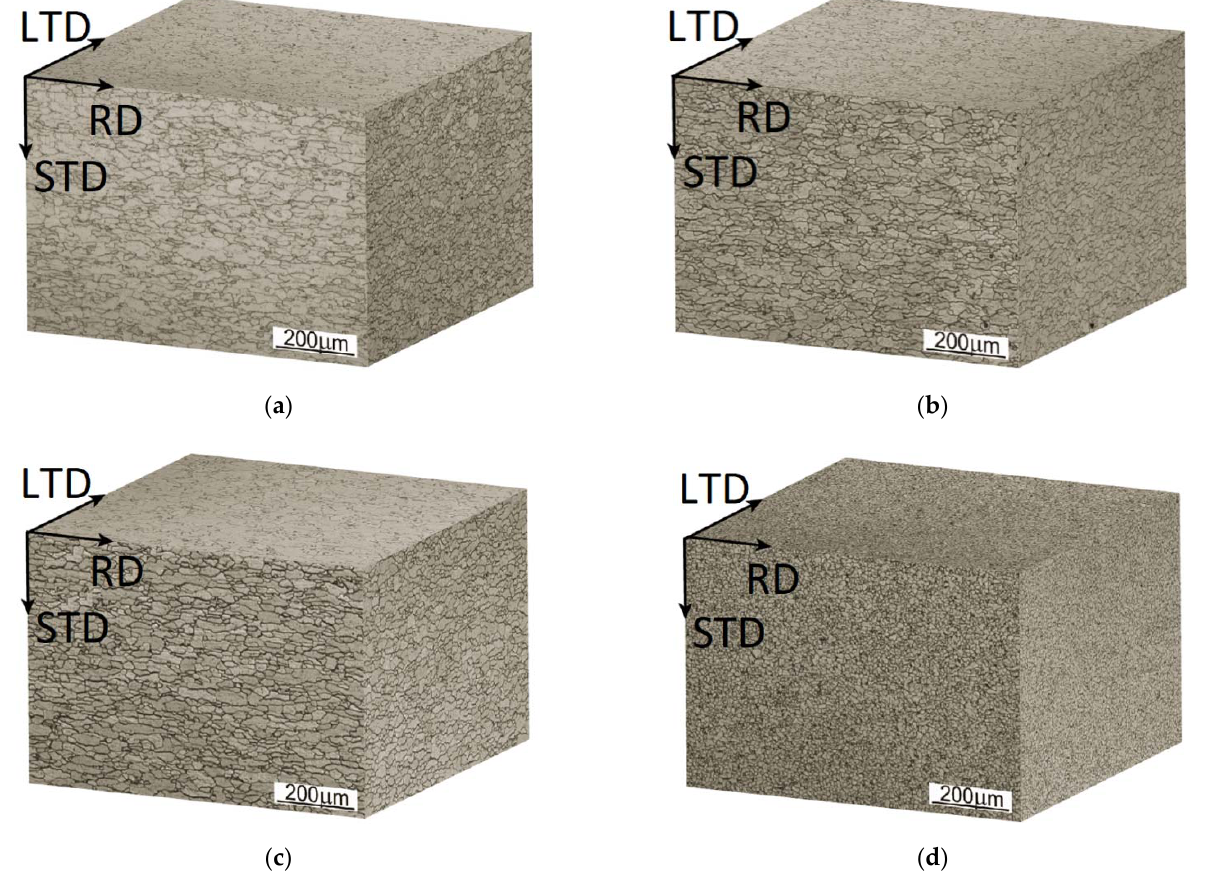
Figure 5. 3D images of the microstructure of the investigated steel sheets: ( a ) DC03; ( b ) DC04; ( c ) DC05; ( d ) DD14. RD—rolling direction; LTD—long transverse direction; STD—short transverse direction. Table 6. The size of the grain cross-sectional area in the tested steels. Plane RD-STD, Plane